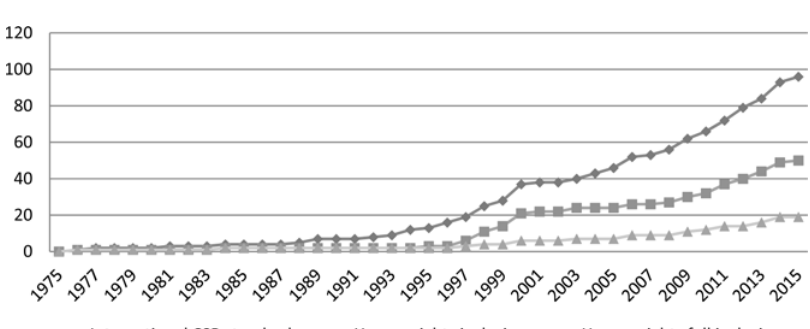
Figure 1: Global CSR Standards and Human Rights